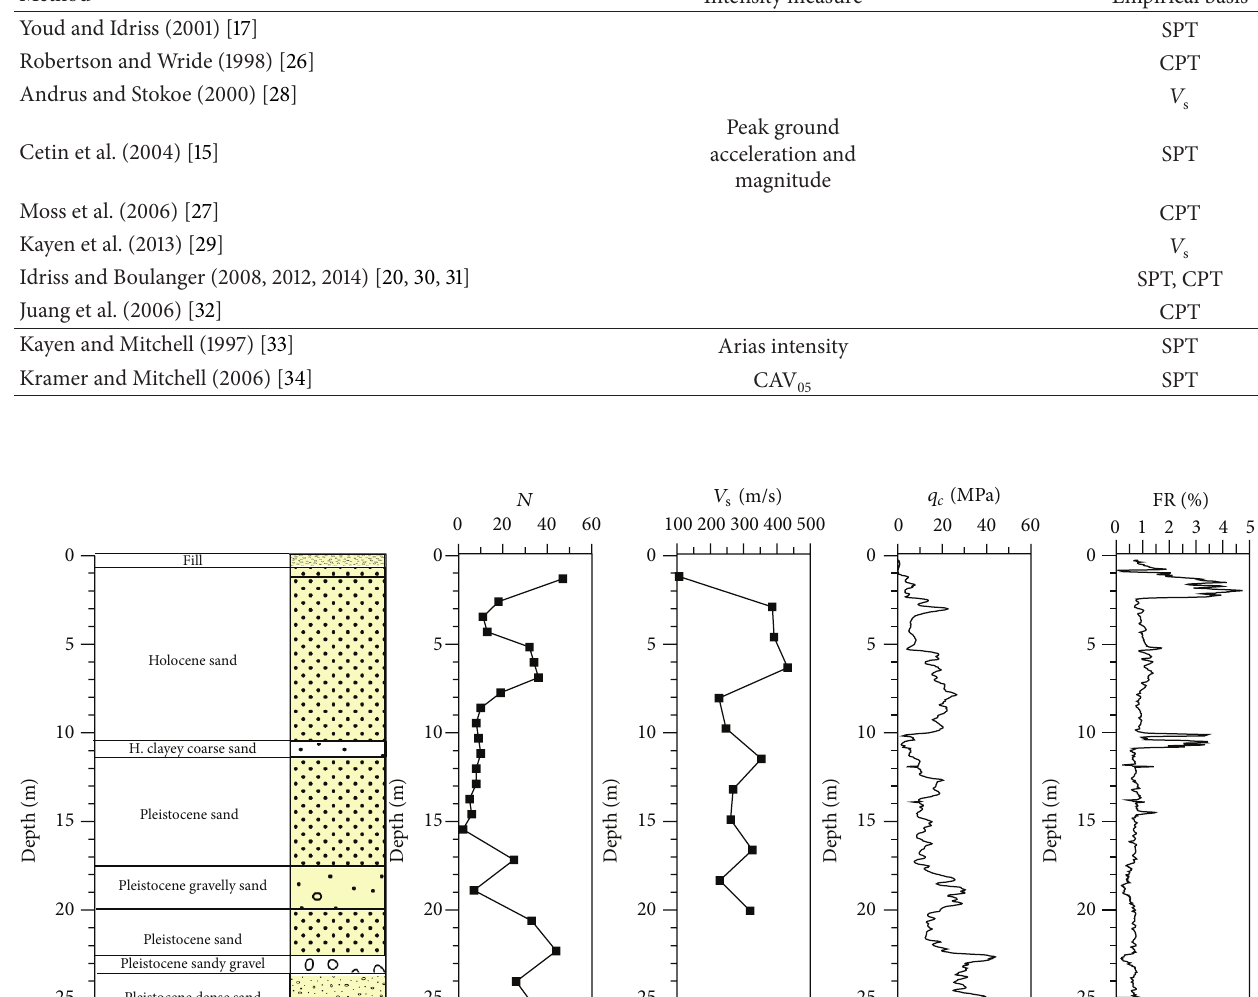
), CPT penetration resistances ( 𝑞 𝑐 ), and friction ratios (FR) measured s